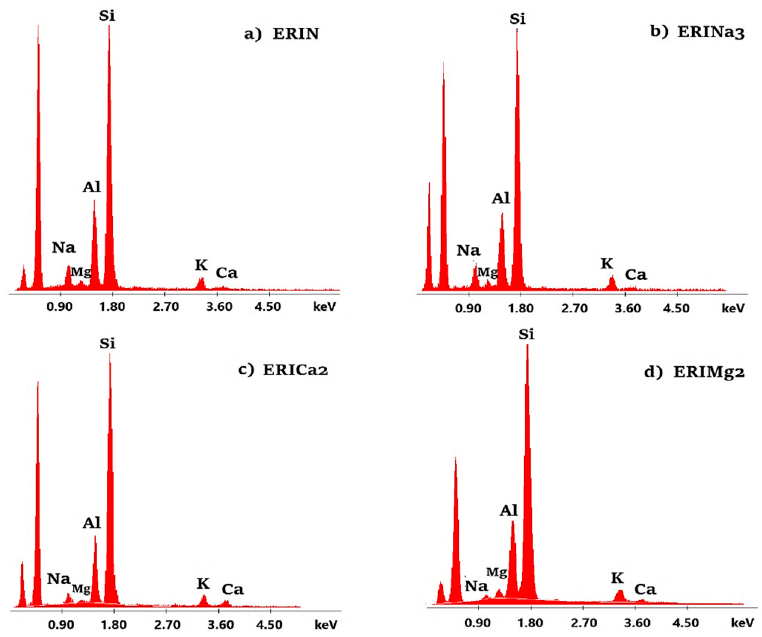
Figure 3. SEM-EDX spectrums of erionite fiber samples: ( a ) ERIN ( b ) ERINa3, ( c ) ERICa2 and ( d ) ERIMg2.